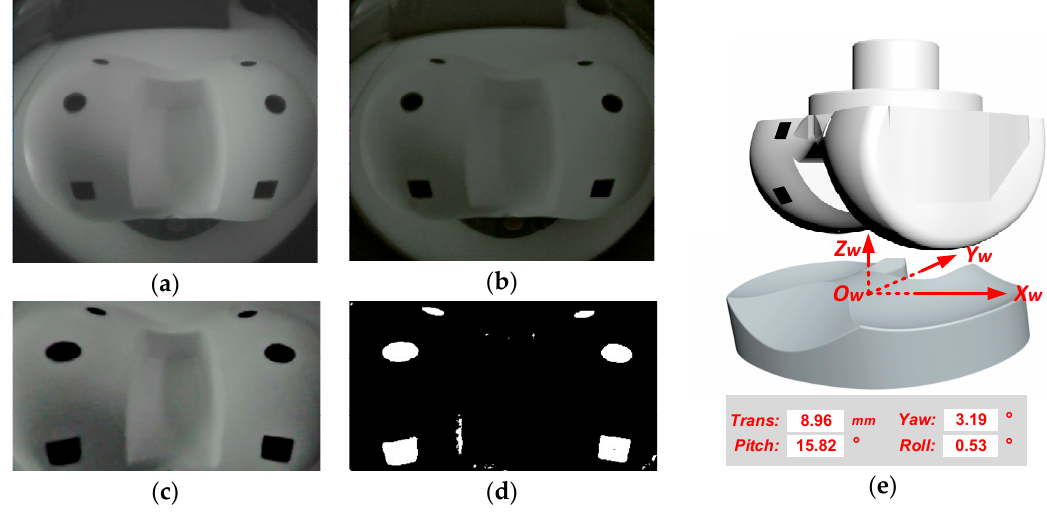
Figure 15. Instant relative pose reconstruction: ( a ) original image, ( b ) after denoising and contrast enhancement, ( c ) after lens distortion correction, ( d ) control point recognition, ( e ) instant pose reconstruction.